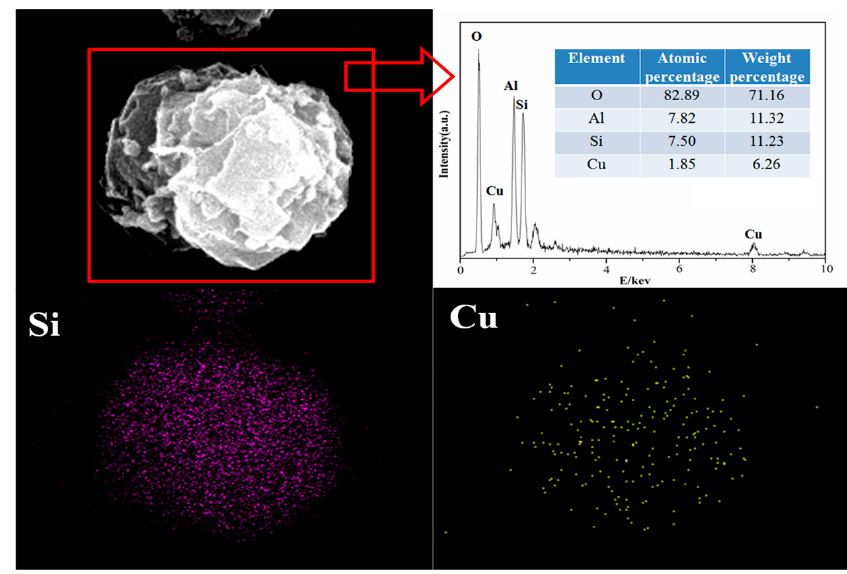
Figure 12. SEM images and EDS analysis of X zeolite adsorbed with Cu 2+ .